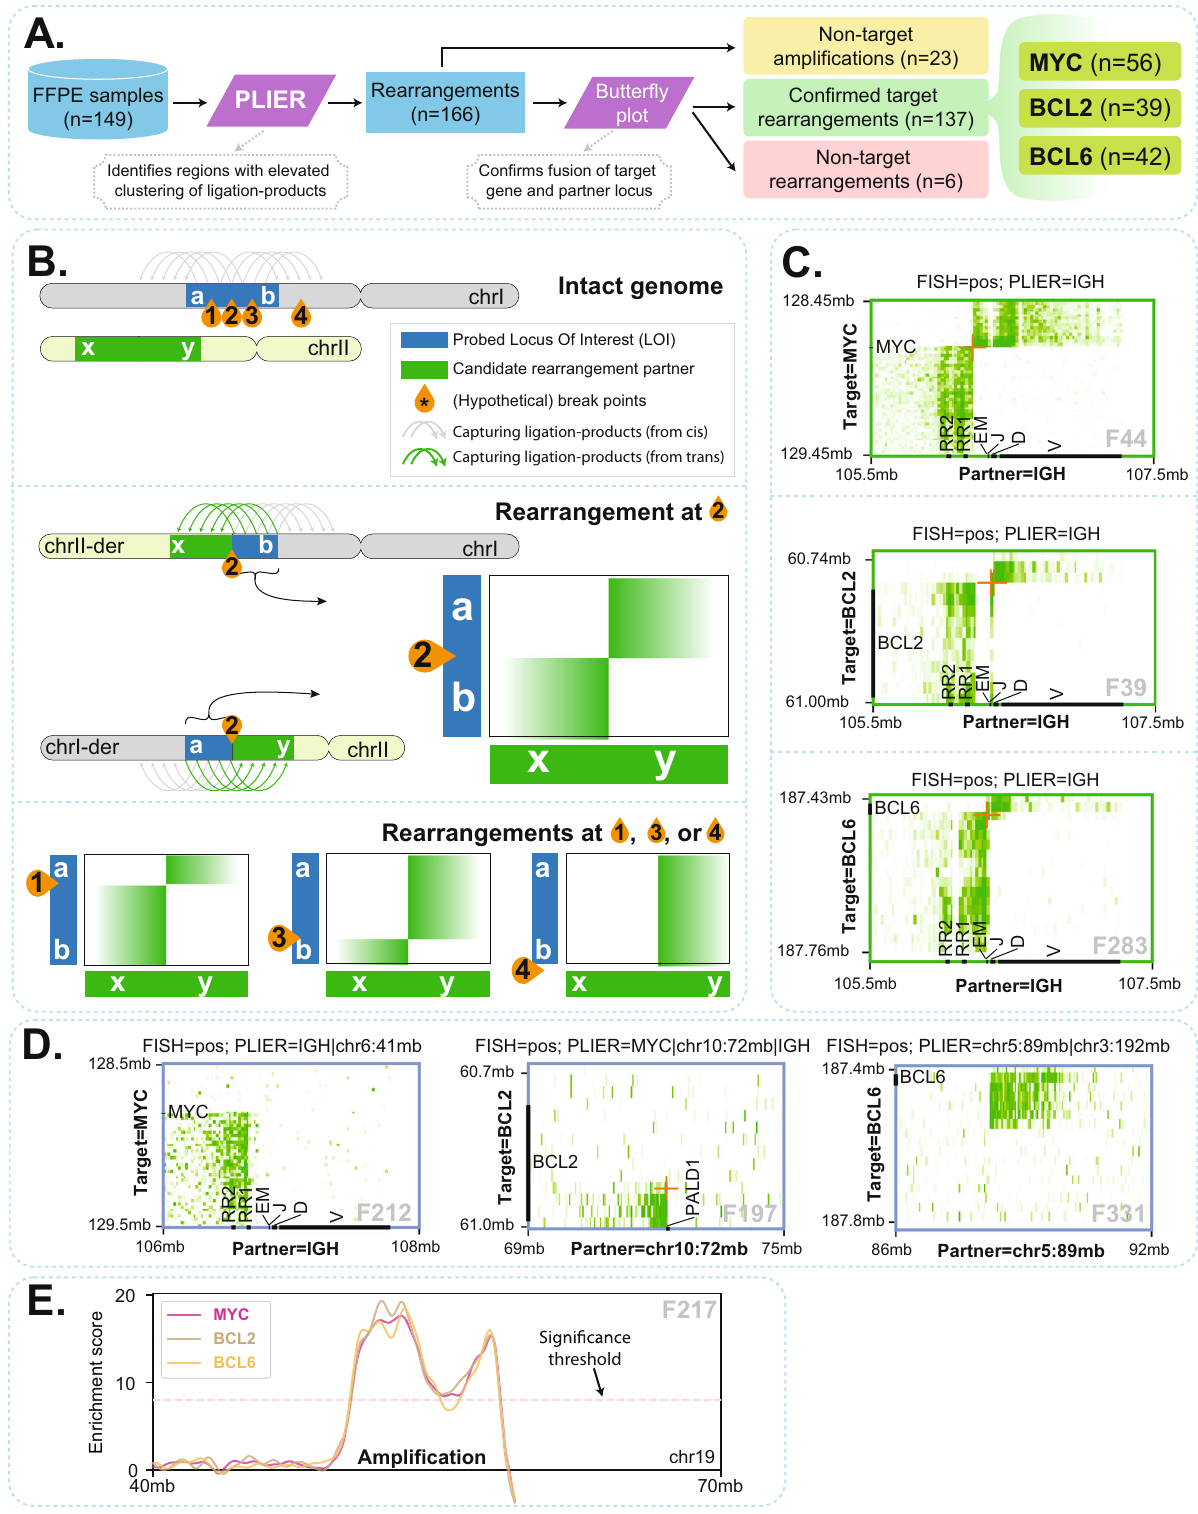
fi rst was gained or ampli fi ed genomic regions (copy number variations); they could be distinguished from true positive rearrangements since PLIER scored them with all target genes (Fig. 2E). PLIER discovered 23 ampli fi cations throughout the genome across all analyzed lymphoma samples. The second bystander category scored by PLIER were genomic rearrange- ments involving the chromosome that contained the target gene,